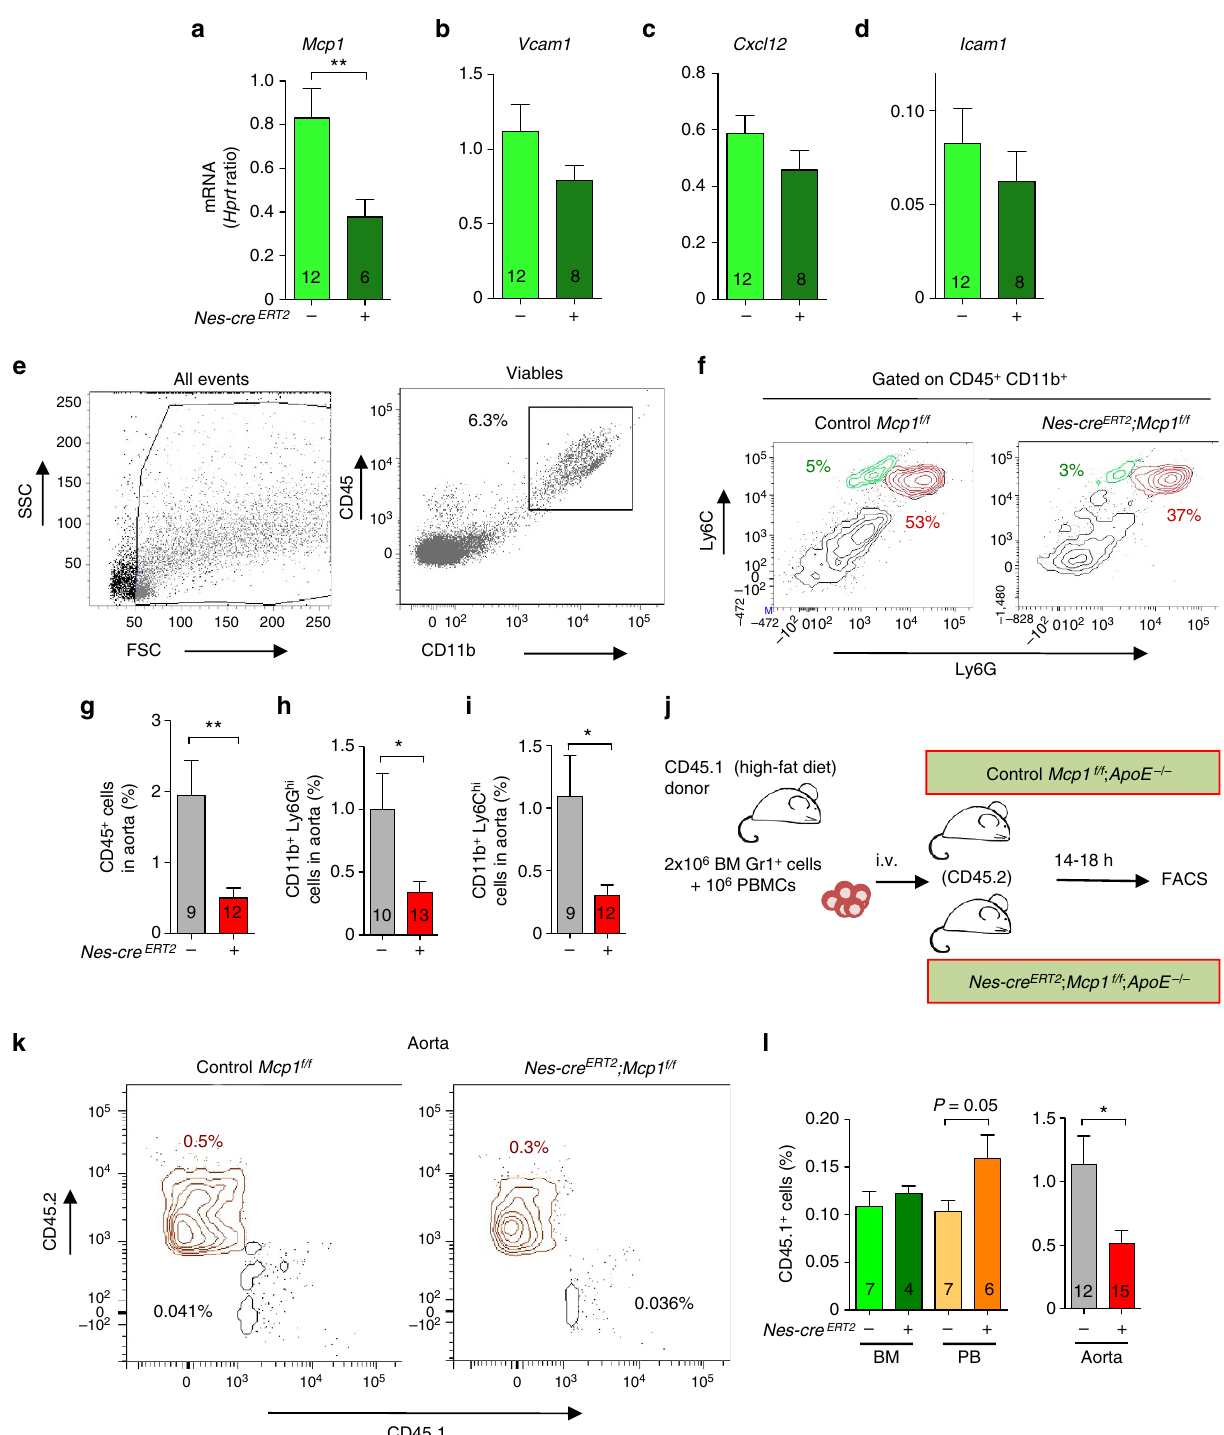
Figure 3 | Mcp1 deletion in nestin þ cells decreases the inflammatory infiltration in the aortic wall. ( a – d ) QPCR analysis of Mcp1, Cxcl12 and Icam1 mRNA in aorta from mice fed with chow after the tamoxifen injection ( n ¼ 6–12). ( e ) Flow cytometry plots of aortic cells (left) and myeloid cells (right). ( f ) Representative flow cytometry diagrams of the aortas depicting inflammatory neutrophils (CD11b þ Ly6G high , red) and inflammatory monocytes (CD11b þ Ly6C high , green) in both groups of mice. Frequency of ( g ) hematopoietic cells ( n ¼ 9–12), ( h ) inflammatory neutrophils ( n ¼ 10–13) and ( i ) inflammatory monocytes in the aortas of Nes-cre ERT2 ;Mcp1 f/f ; ApoE (cid:2) / (cid:2) mice and control littermates fed with HFD for 2 months ( n ¼ 9–12). ( j ) Design of adoptive transfer experiments. BM Gr1 þ leukocytes and peripheral blood mononuclear cells (PBMCs) from CD45.1 mice fed with HFD were intravenous transplanted into Nes-cre ERT2 ;Mcp1 f/f ; ApoE (cid:2) / (cid:2) mice and control littermates previously treated with tamoxifen and fed with HFD for 2 months. ( k ) Representative flow cytometry diagrams of CD45.1 þ and CD45.2 þ cells in the aortas of Nes-cre ERT2 ;Mcp1 f/f ; ApoE (cid:2) / (cid:2) mice and control littermates. ( l ) Frequency of CD45.1 þ cells in the BM, the peripheral blood (PB) and the aorta of both groups of mice ( n ¼ 6–15). ( e , f , k ) The frequencies of the gated populations are indicated. Data are means ± s.e.m.; n and P values are indicated; * P o 0.05, unpaired two-tailed t test.